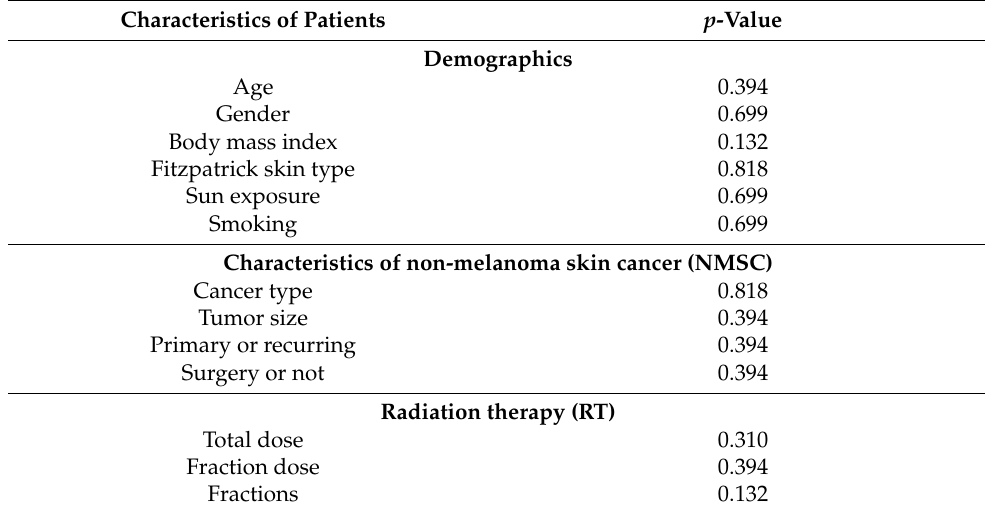
Table 2. p -values for patients’ baseline characteristics. Values lower than or equal to 5% ( p ≤ 0.05) indicate a statistical